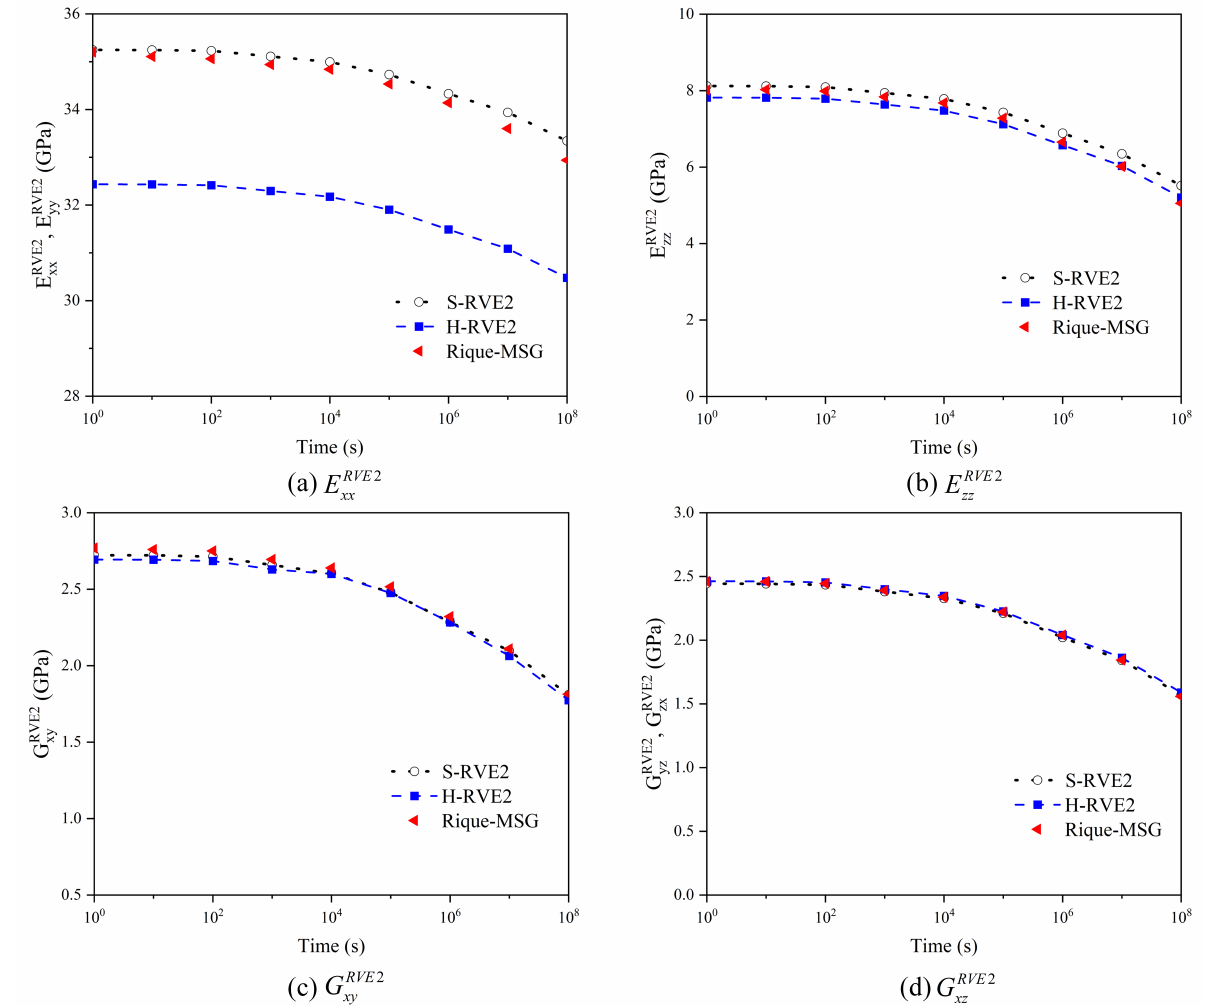
Figure 7.Figure 7. Equivalent viscoelasticity of 2D woven